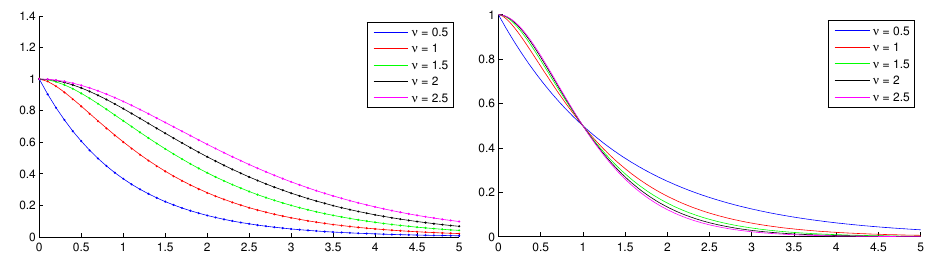
Fig. 1. Solid lines show the analytical kernels for different values of ν and the dots show the numerical kernel (left) and analytical kernels with scaled r h